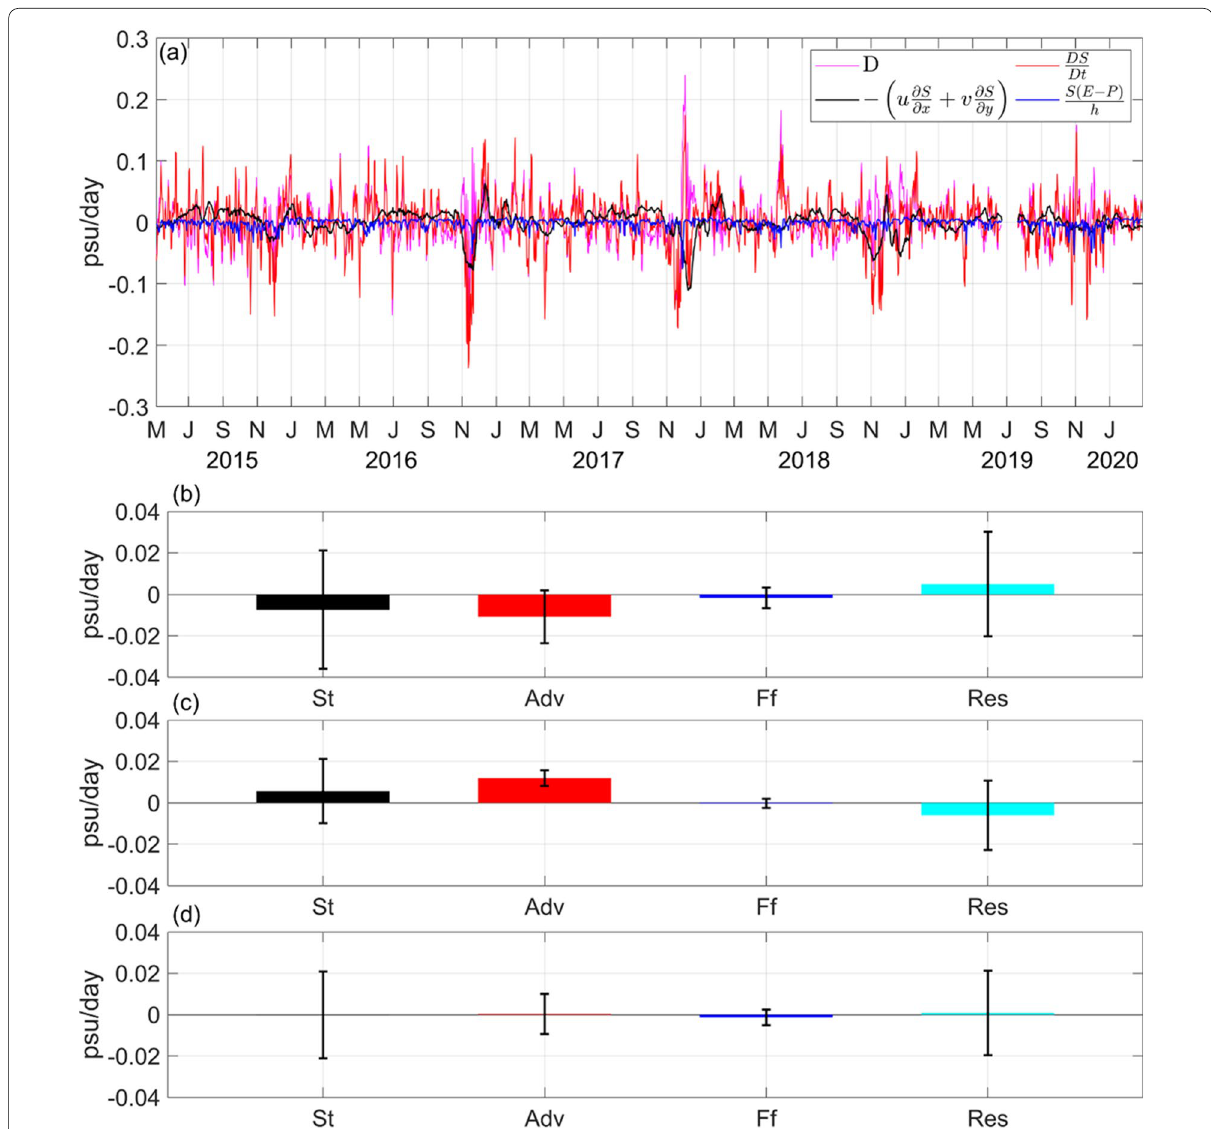
Fig. 6 a Time series of salinity budget equation in region B (74°–82°E, 3–8°N) during 2015–2019. b Wintertime mean salinity budget terms (bars, psu/day) and the half of the standard error. c Summertime mean salinity budget terms (bars, psu/day) and the half of the standard error. d Five-year mean salinity budget terms (psu/day) and the half of standard error. St represents the salinity tendency, Ff represents the freshwater flux term, and Adv represents the horizontal advection terms. Res represents the residual term calculated by